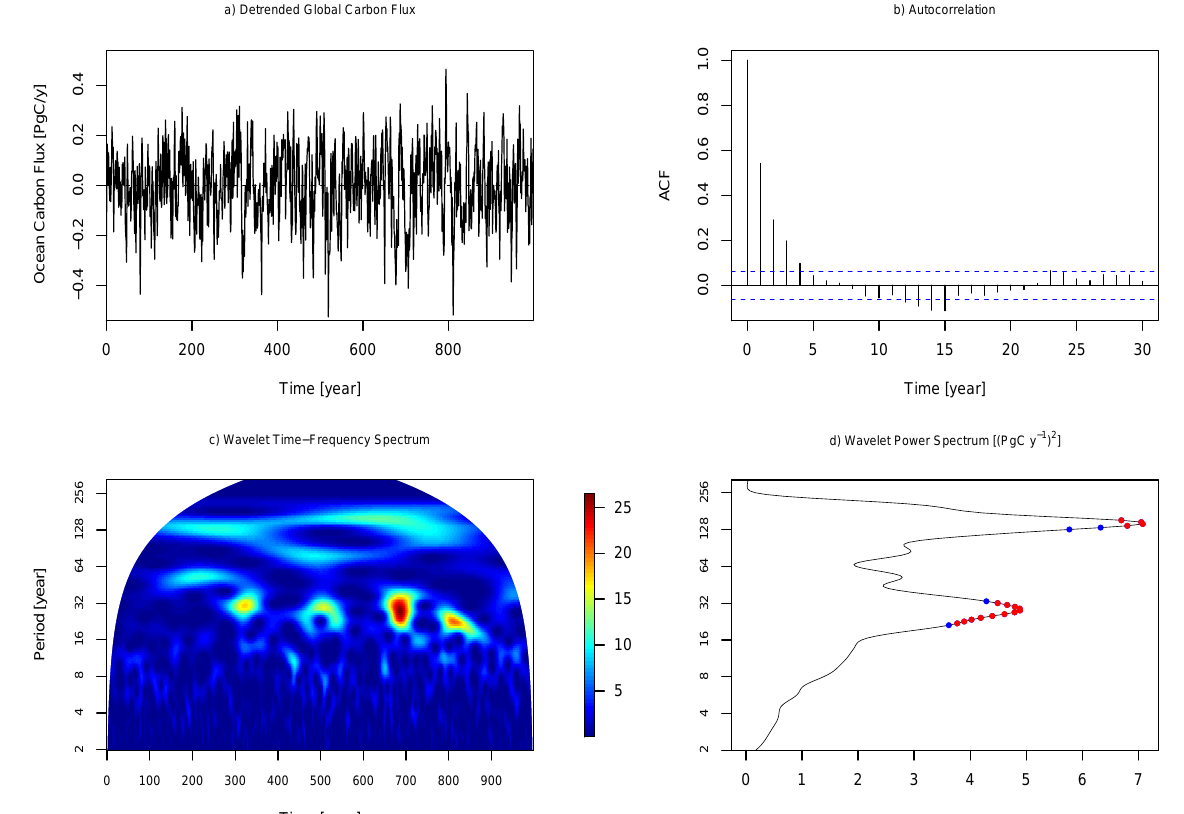
Fig. 2. Interannual time-series of the drift-corrected globally integrated ocean carbon flux (in PgCyr − 1 ) is represented in (a) . The autocor-